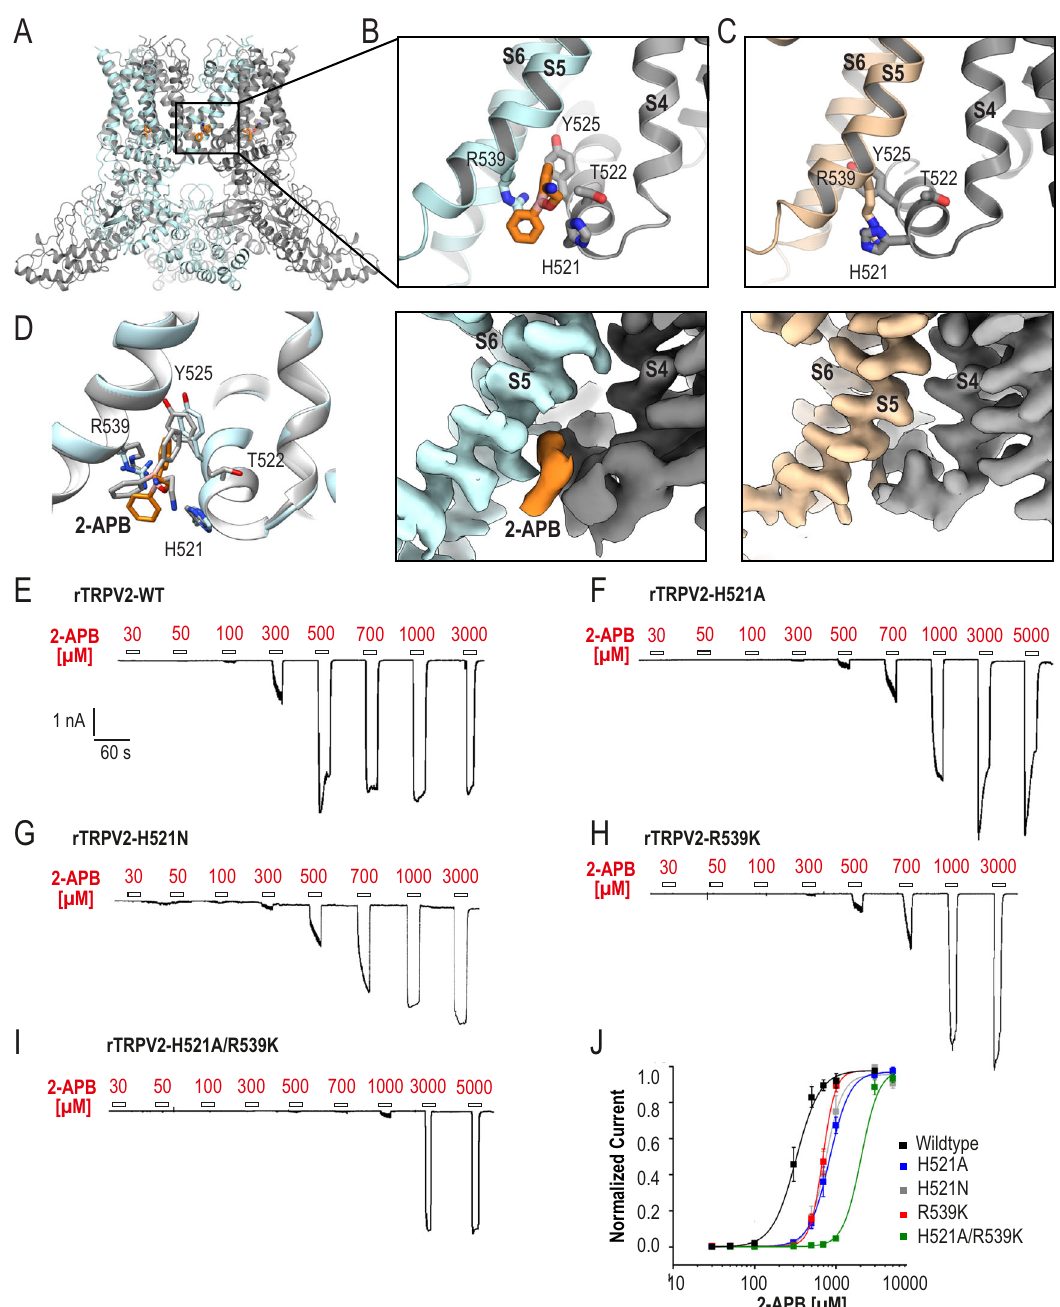
Fig. 2 Identi fi cation and validation of 2-APB binding site. A Cartoon representation of TRPV2 2APB_IAC . Cartoon representation (upper panel) and map density (lower panel) of the 2-APB binding site in TRPV2 2APB_IAC ( B ) and TRPV2 Apo1 (PDB 6U84) ( C ). One monomer is colored light cyan or wheat, the adjacent monomer is colored gray; 2-APB is colored orange. Maps contoured at σ = 5. D Structural comparison of the top 2-APB docking model (gray) and TRPV2 2APB_IAC (light cyan and orange). Representative whole-cell patch clamp current traces displaying a concentration-dependent activation of wildtype rat TRPV2 ( E ), His521Ala rat TRPV2 ( F ), His521Asn ( G ), Arg539Lys rat TRPV2 ( H ), and His521Ala/Arg539Lys rat TRPV2 ( I ) by 2-APB. Cells were held at − 60 mV and increasing concentrations of 2-APB were applied. J Dose – response curves for 2-APB-evoked activation of wildtype rat TRPV2 (black, EC 50 = 322 ± 27 μ M n = 8), Arg539Lys rat TRPV2 (red, EC 50 = 683 ± 78 μ M, n = 4), His521Ala rat TRPV2 (blue, EC 50 = 991 ± 131 μ M, n = 8), and His521Ala/Arg539Lys rat TRPV2 (green, EC 50 = 1753 ± 125 μ M, n = 6). Data are shown as mean ± S.E.M. Current amplitudes were determined for each concentration and normalized to the maximal amplitude obtained with 3000 μ M 2-APB. The solid lines represent fi ts calculated with the Hill equation. Source data are provided as a Source Data fi